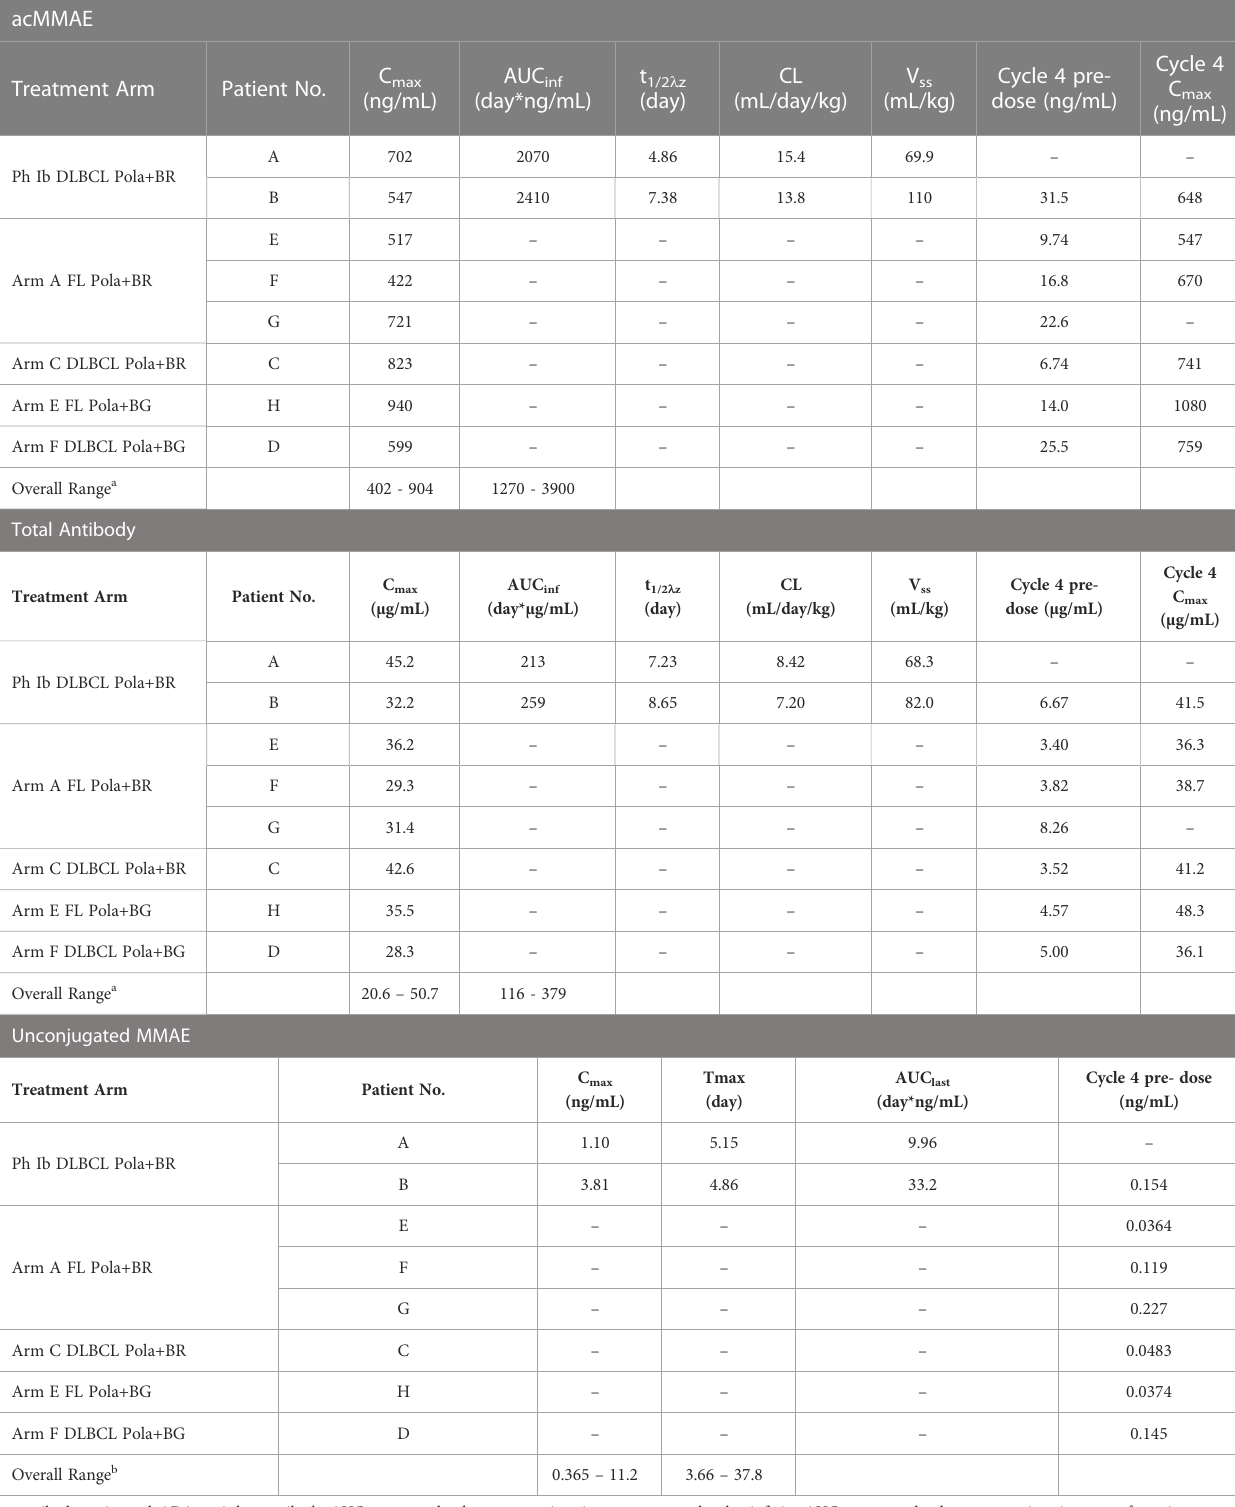
TABLE 5 Individual polatuzumab vedotin PK parameters in patients with positive-ADA status in Study